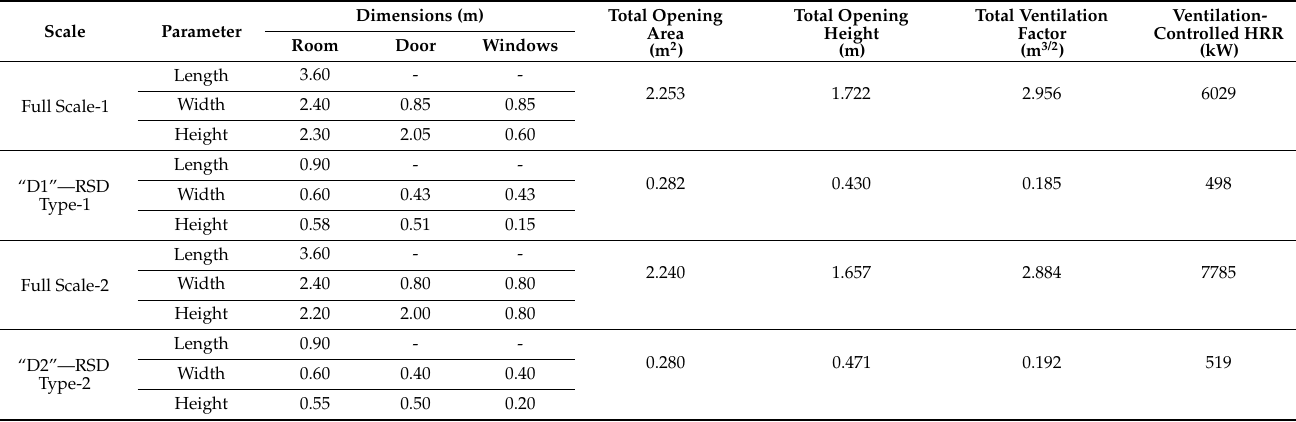
Figure 4. Pictorial representation of 19 test setups showing dwelling layouts (top) and test setups. Steel-clad dwellings are shown in black, timber-clad dwellings in brown and ignited dwellings with the fire symbol. Table 1. Dimensions of 1 th scale reduced scale 4